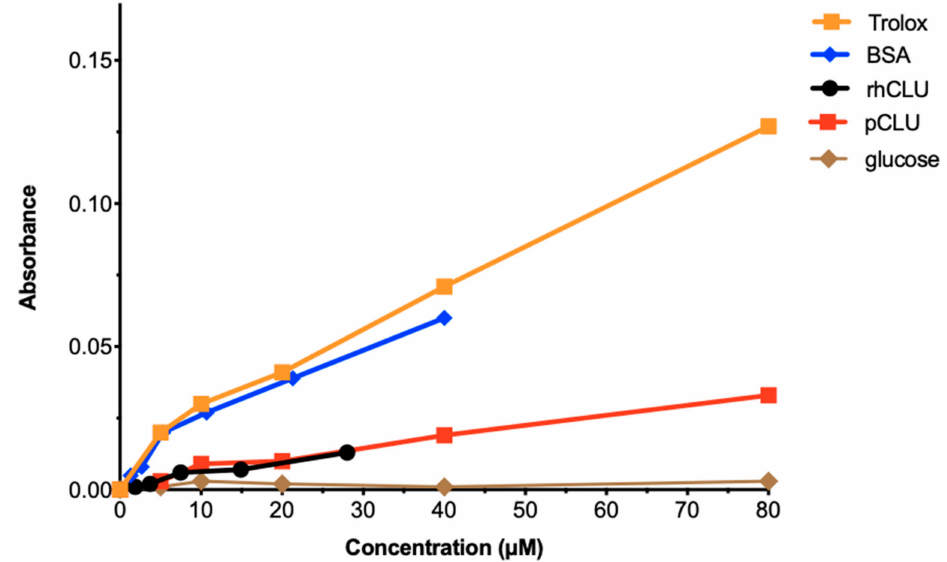
Figure 6. The antioxidant capacity of CLU is low. Total antioxidant capacity for human pCLU and rhCLU- α C-H2ST (rhCLU) was compared using the OxiSelect™ Total Antioxidant Capacity Assay Kit (Cell Biolabs, Inc., San Diego, CA, USA), according to the manufacturer’s directions. Absorbance at 490 nM was determined with a Synergy H1 microplate reader at the beginning and end of the reaction, and the difference was calculated and plotted on the graph. Bovine serum ALB (BSA) and Trolox served as positive standards and glucose served as a negative